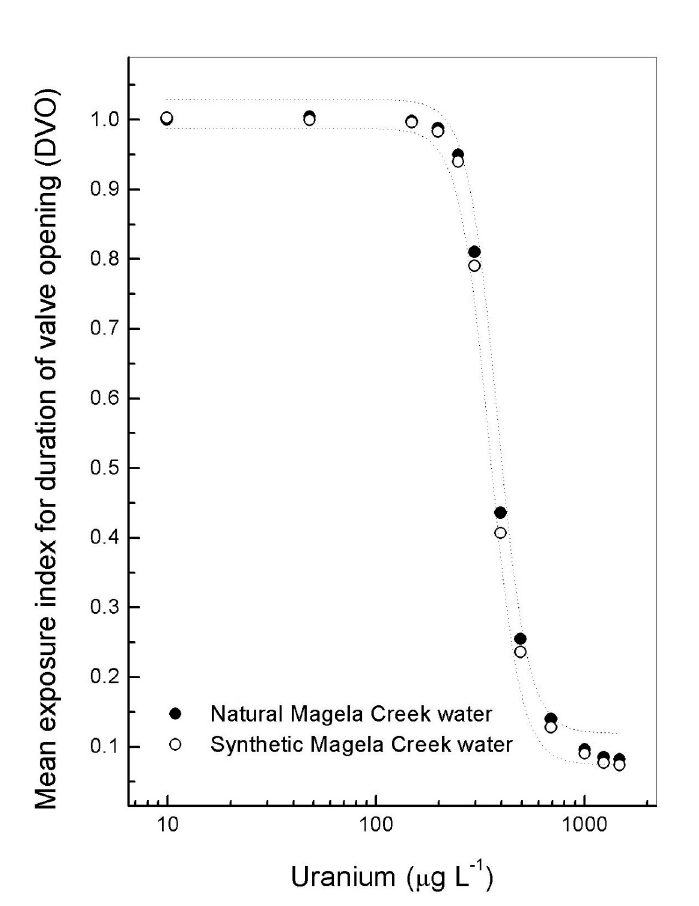
FIGURE 6. Concentration-response relationships of the DVO for V. angasi exposed to U in natural and synthetic Magela Creek water at pH 5.5 with 5.7 mg l -1 fulvic acid. Each plotted point represents the mean response of six bivalves. Error bars are excluded for clarity. The dotted lines represent the upper and lower 95% confidence bands around the sigmoidal